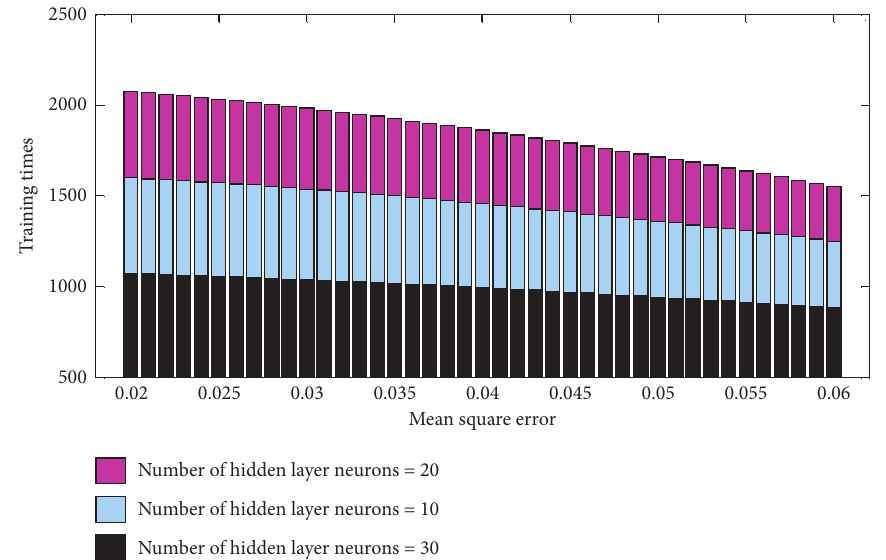
Figure 6: Comparison of the relationship between the number of errors of different hidden layers and the number of training